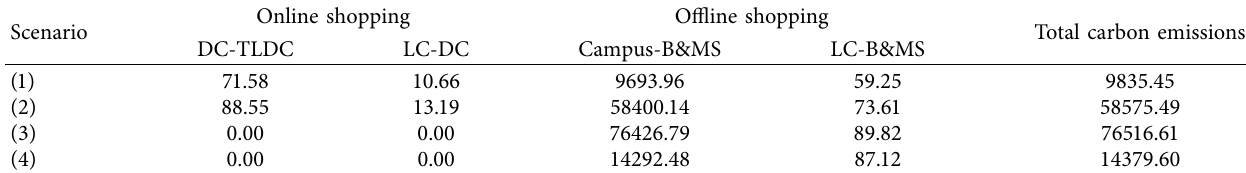
Table 8: Carbon emissions related to shopping